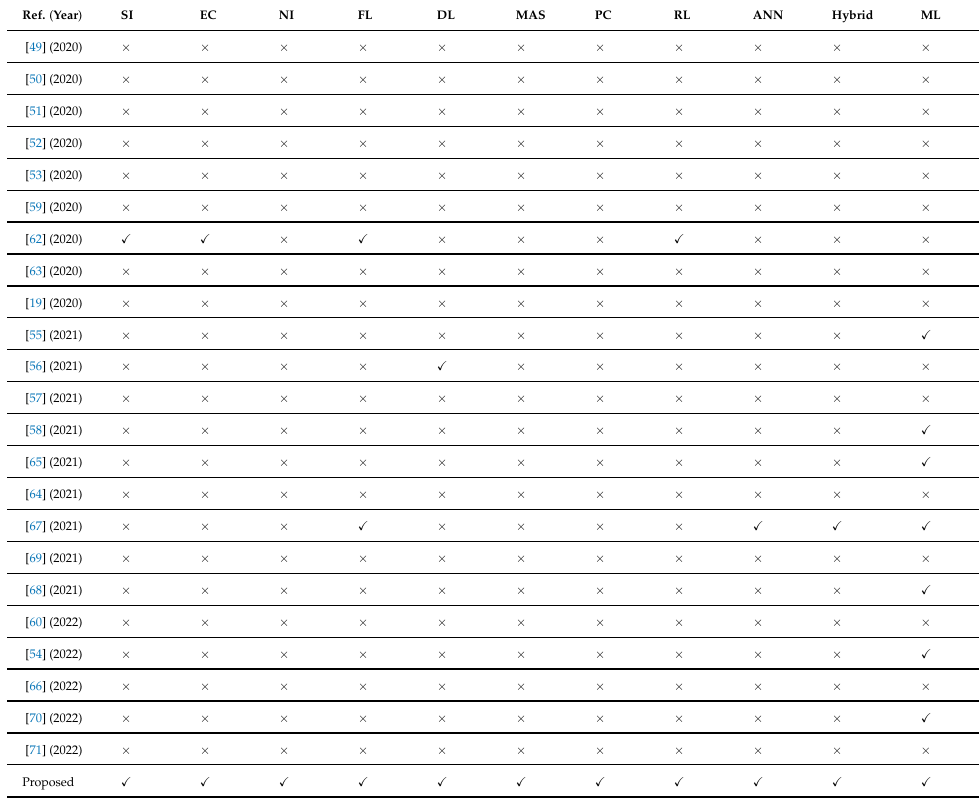
Table 2. Comparison: Proposed work with existing related reviews of security, fault detection and tolerance, and quality of service in WSNs with respect to different AI